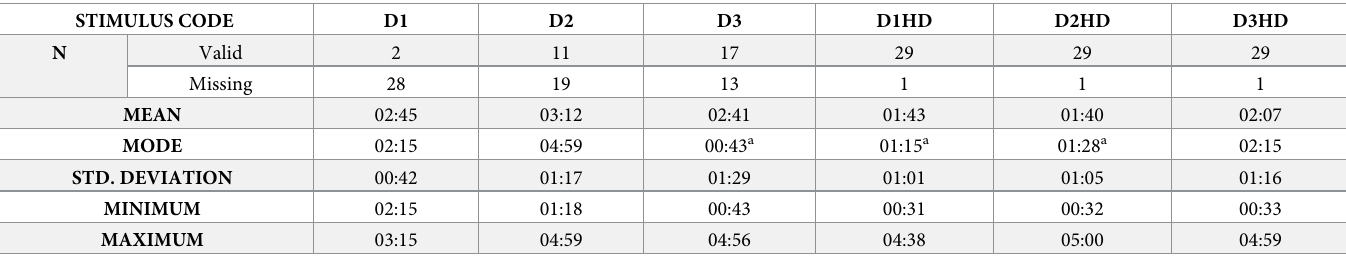
differentiation. For task 1, in the case of using the same distances between symbols, but above 1 mm, the height differentiation significantly impacts the time of symbol identification. For D2HD-D2 Table 3. Task 1